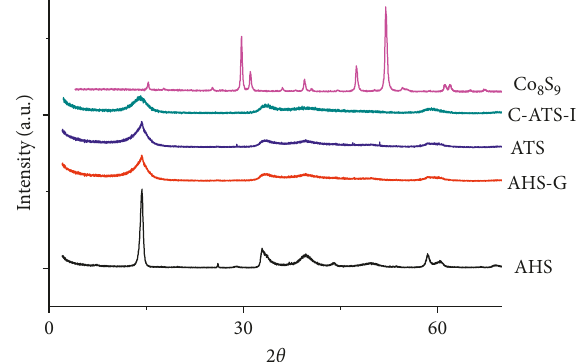
Figure 1: XRD patterns of the AHS, AHS-G, ATS, C-ATS-I, and Co